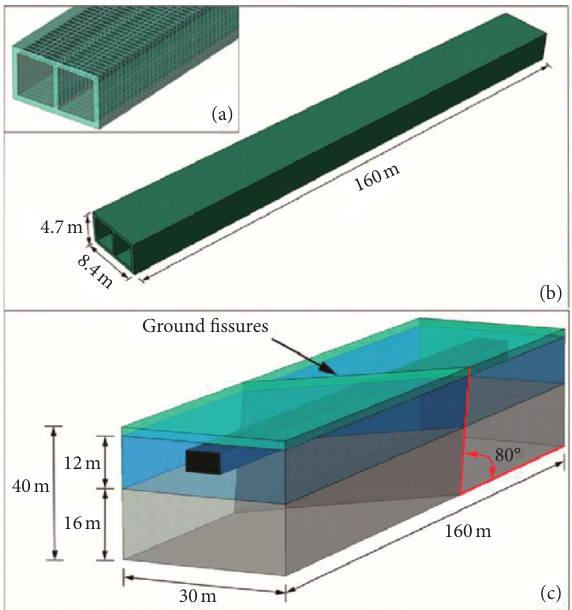
Figure 4: The model of utility tunnel. (a) The utility tunnel with reinforcing bar. (b) The size of utility tunnel. (c) Assembly result of the model. Table 1: Parameters of concrete damage plastic model [22].